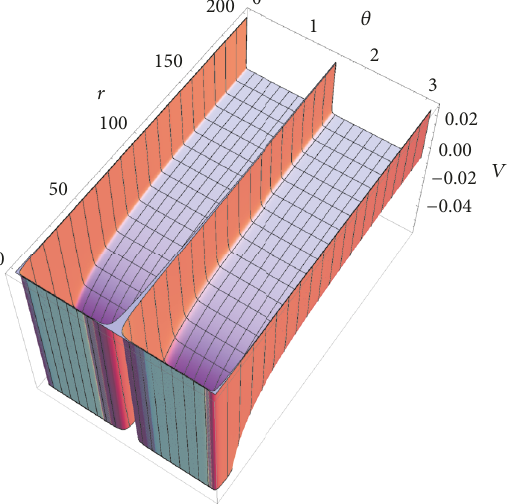
Figure 1: 𝑉(𝑟, 𝜃) as the functions of variables 𝜃 and 𝑟 .